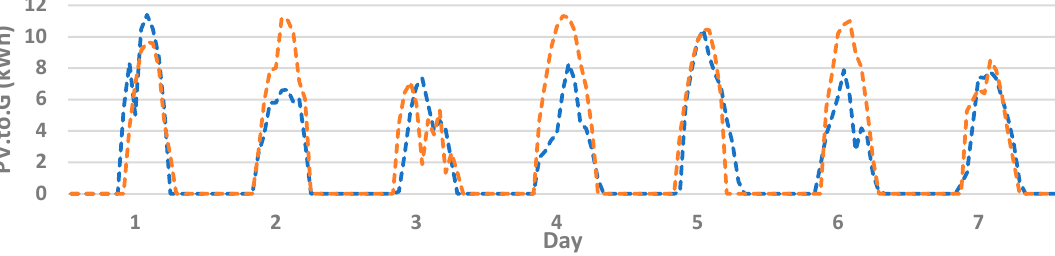
Figure 8. Energy transmission from PV panels to the grid, for a single dwelling. Comparison between the most and least probable scenarios (blue and orange) for one week of April. Source: self-elaboration.